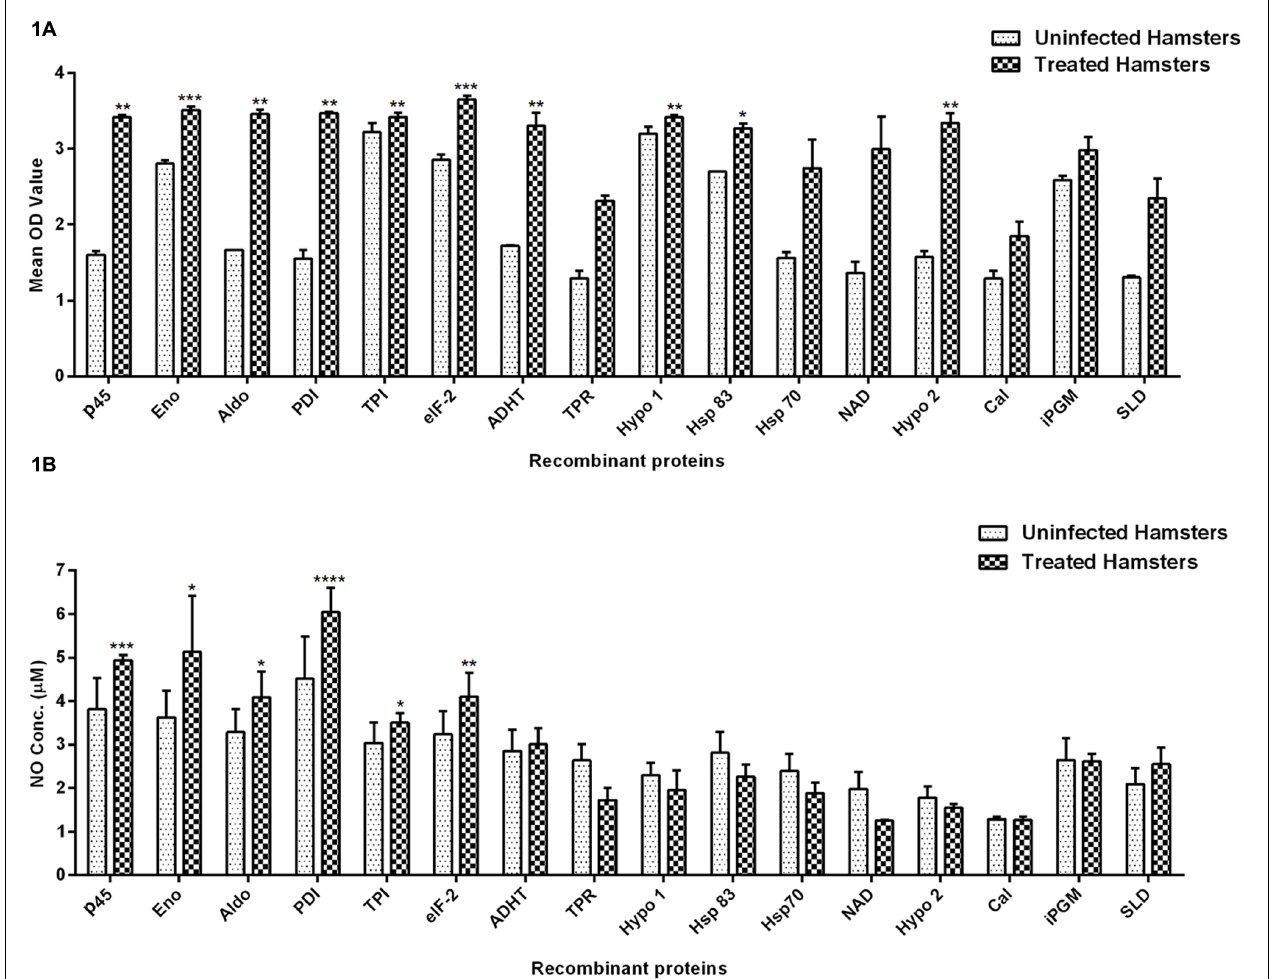
FIGURE 1 | Lymphoproliferative response and NO production. (A) LTT response in lymph node cells of treated Leishmania -infected hamsters in response to 15 recombinant proteins and SLD (10 µ g/ml each) and (B) Nitric oxide production measured by Griess reagent in supernatants collected from J774 A.1 macrophage cultures 24 h after incubation. Each bar represents the pooled data (mean ± SE). Significance values indicate the difference in stimulation between the SLD and the recombinant proteins ( ∗ p < 0.05, ∗∗ p < 0.01, ∗∗∗ p < 0.001, and ∗∗∗∗ p <